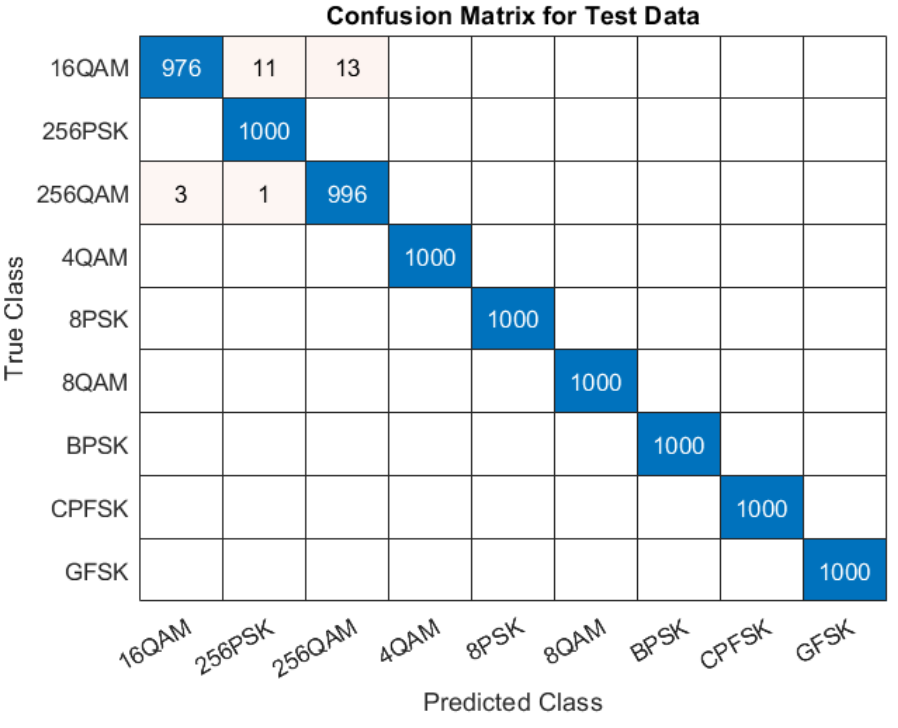
Figure 8. Confusion Matrix for Case-III at SNR = 10